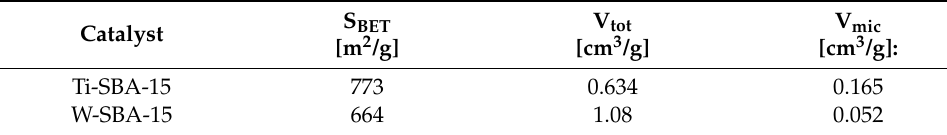
Figure 3. Pore size distribution calculated using the BJH method. Table 1. Textural parameters of Ti-SBA-15 and W-SBA-15.